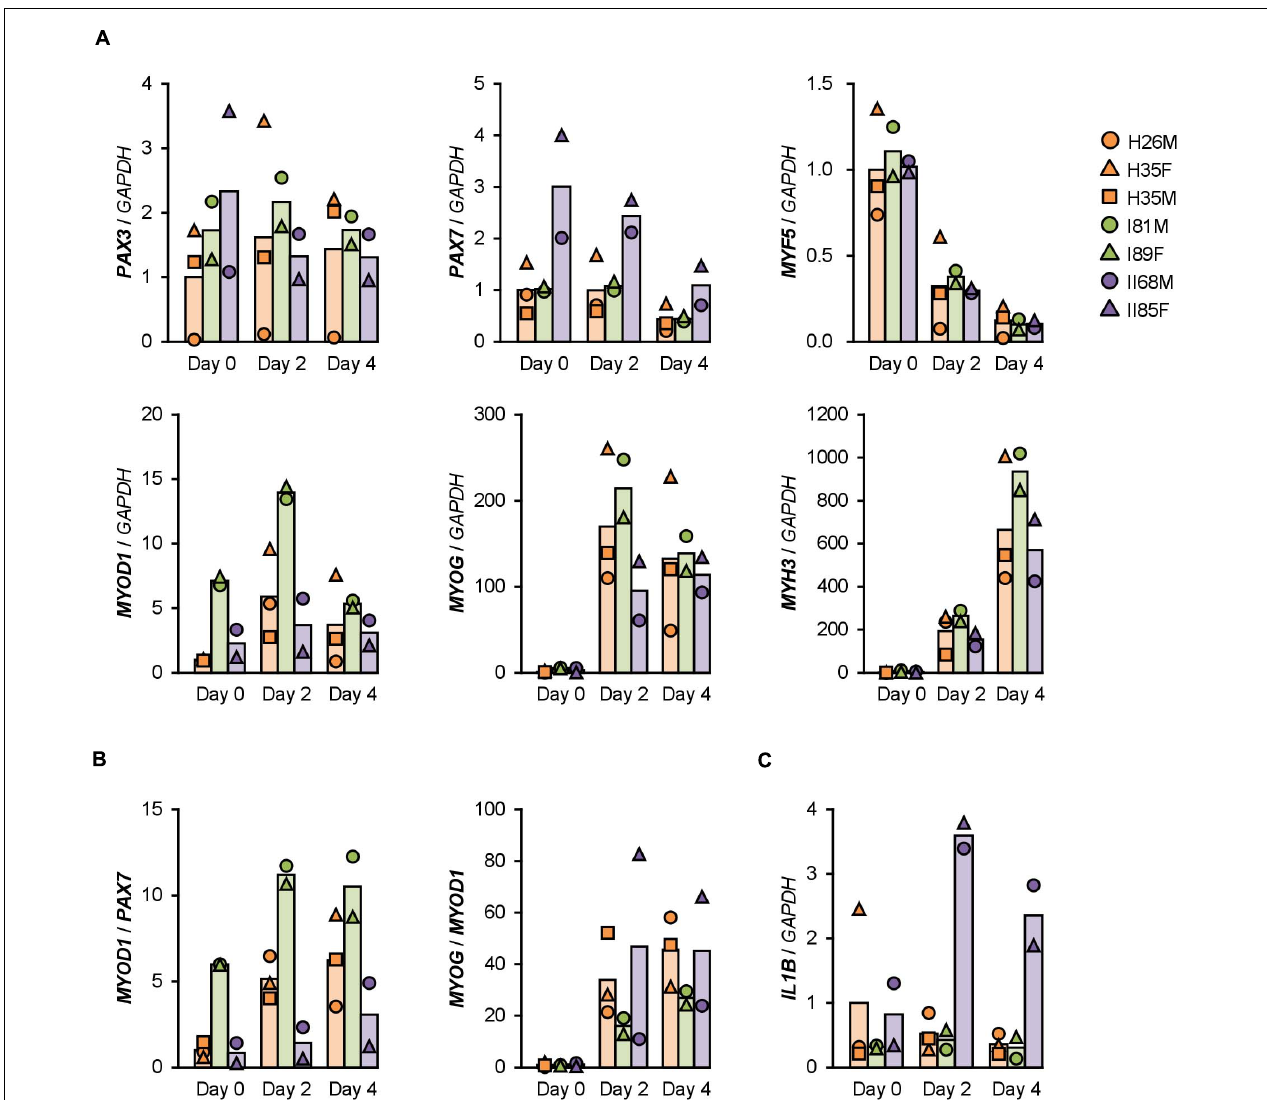
FIGURE 2 | Gene expression patterns altered in DM myoblasts. (A–C) qPCR results of gene expression in the hMBs differentiated in DIM-NG on days 0, 2, and 4. Bars indicate mean values of each group. The mean value of healthy myoblasts on day 0 was set to 1.0 for each